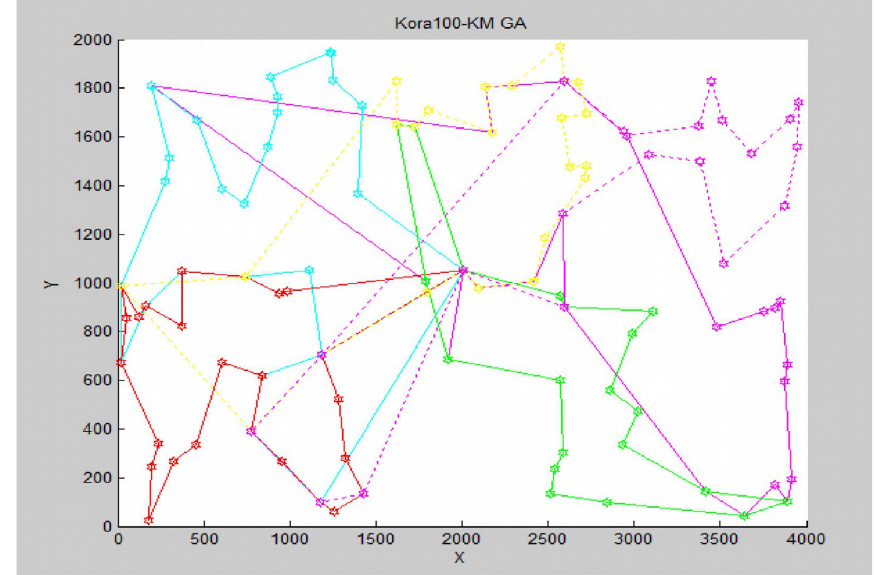
Figure 2. Clusters formed for instance KorA100 by KM-GA (MATLAB